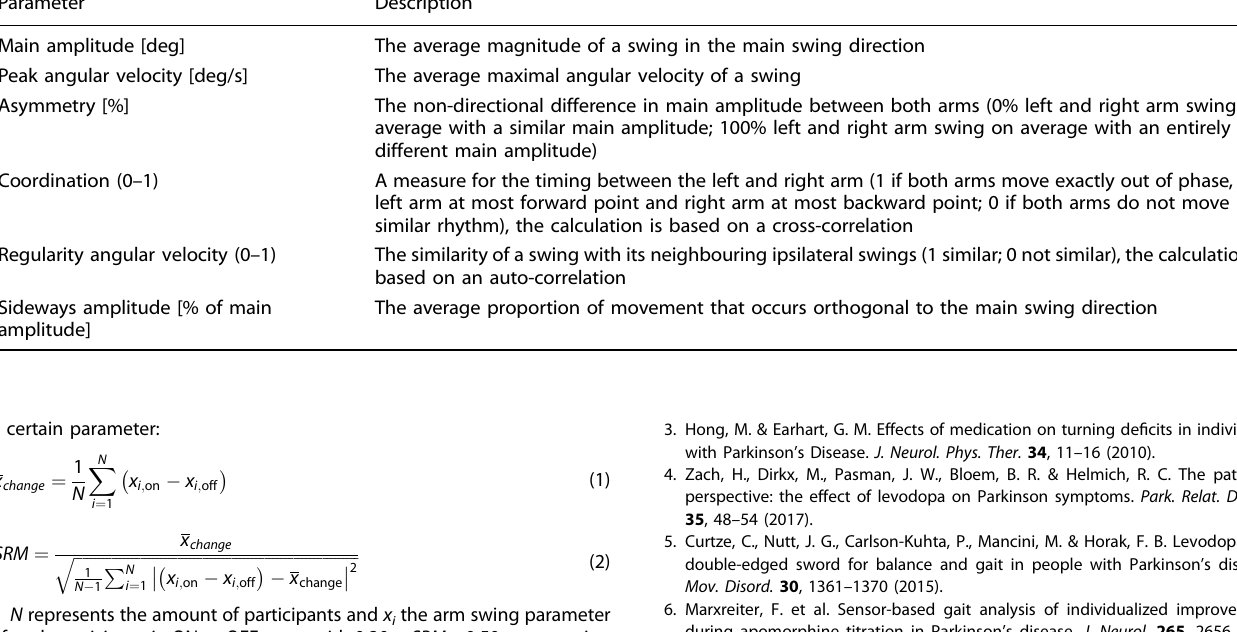
Table 4. Description of the arm swing parameters. Exact calculations of the parameters can be found in 23 . Parameter